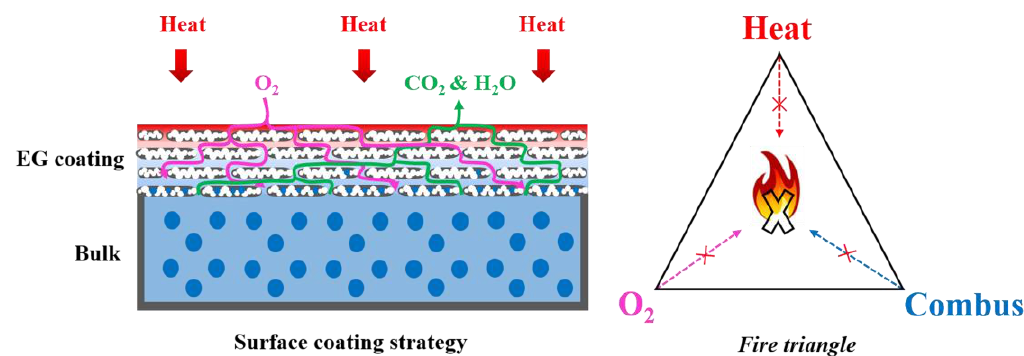
Figure 8. TGA curves of different flame-retardant coatings.